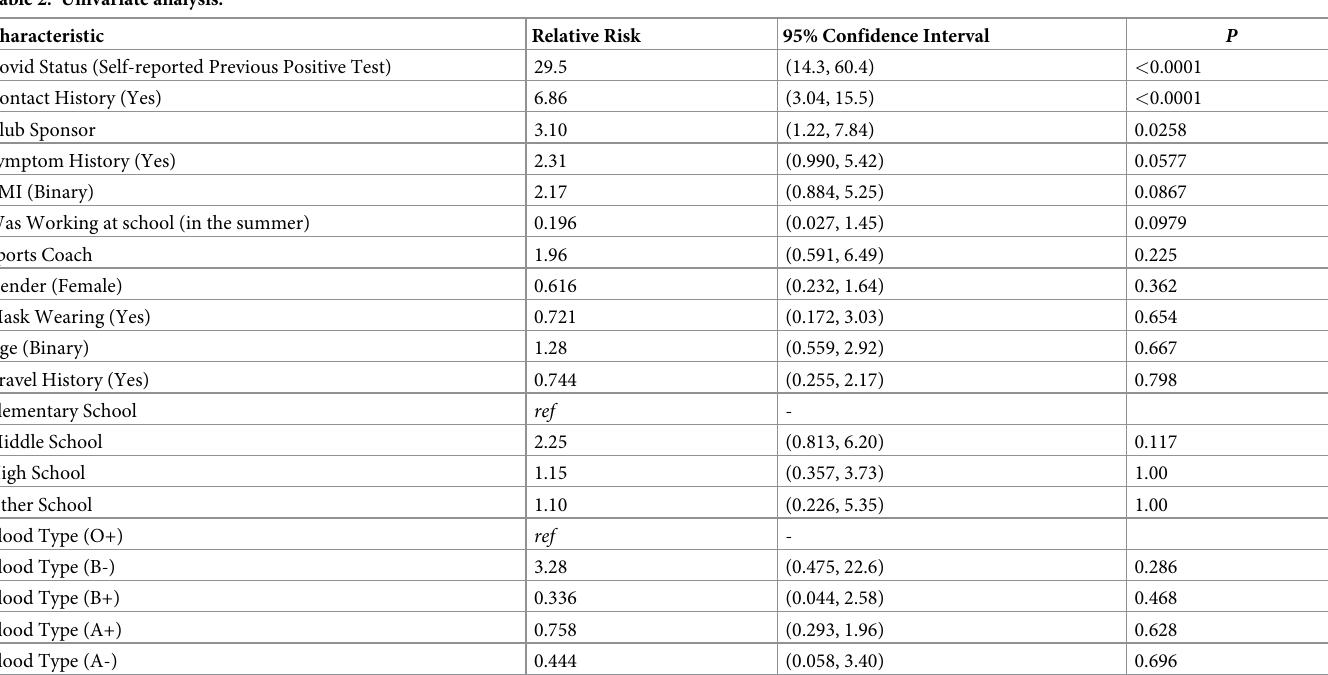
Table 2. Univariate analysis.